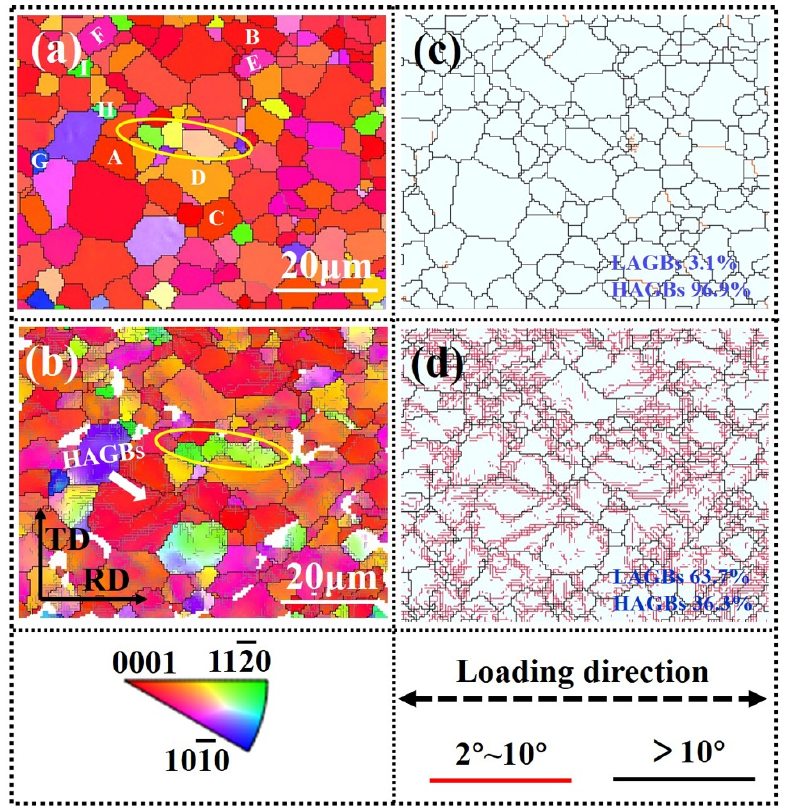
Figure 4. The IPF colored and grain boundary map of Zircaloy-4 after tensile test along RD at different strains, ( a , c ) 0.00%, ( b , d ) 6.64%. The legend that corresponds to the IPF colored map is shown in the bottom left; red, green, and blue show that the grain possesses the <0001>, <1120>, and <1010> orientations, respectively. This legend is applied in the following text.